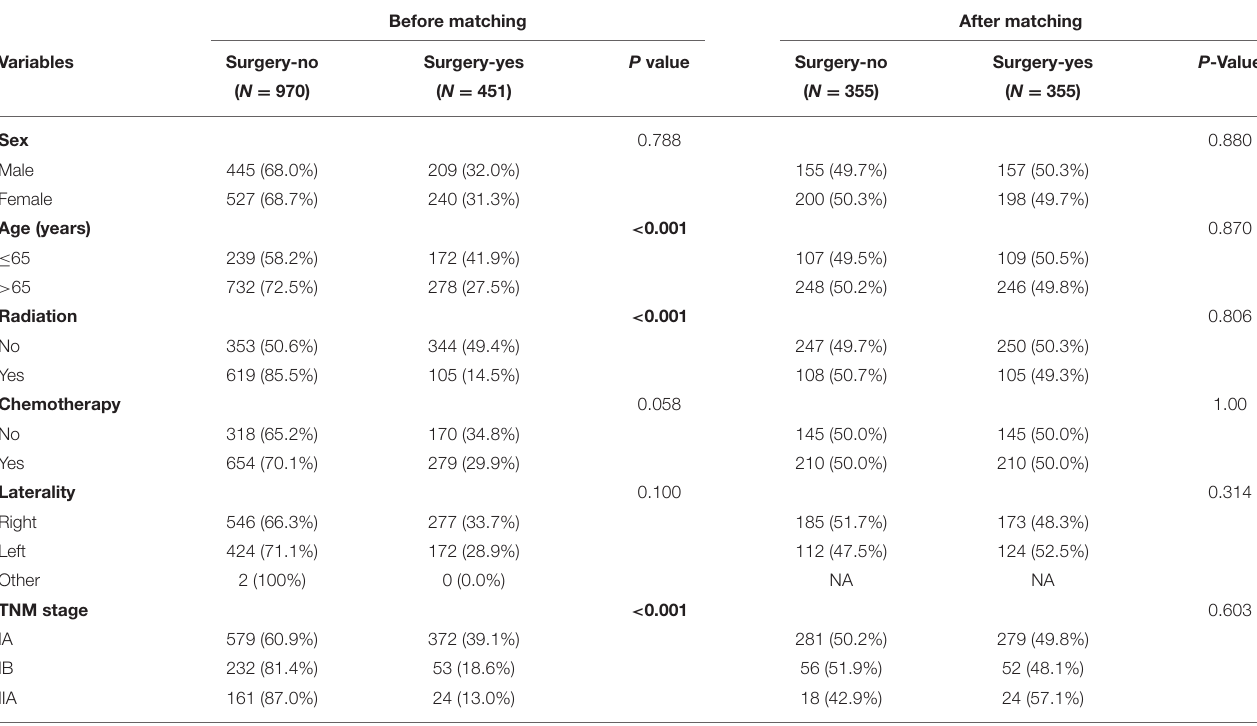
TABLE 2 | The clinicopathological characteristics of patients before matching and propensity scored-matched patients. Before matching After matching Variables Surgery-no Surgery-yes P value Surgery-no